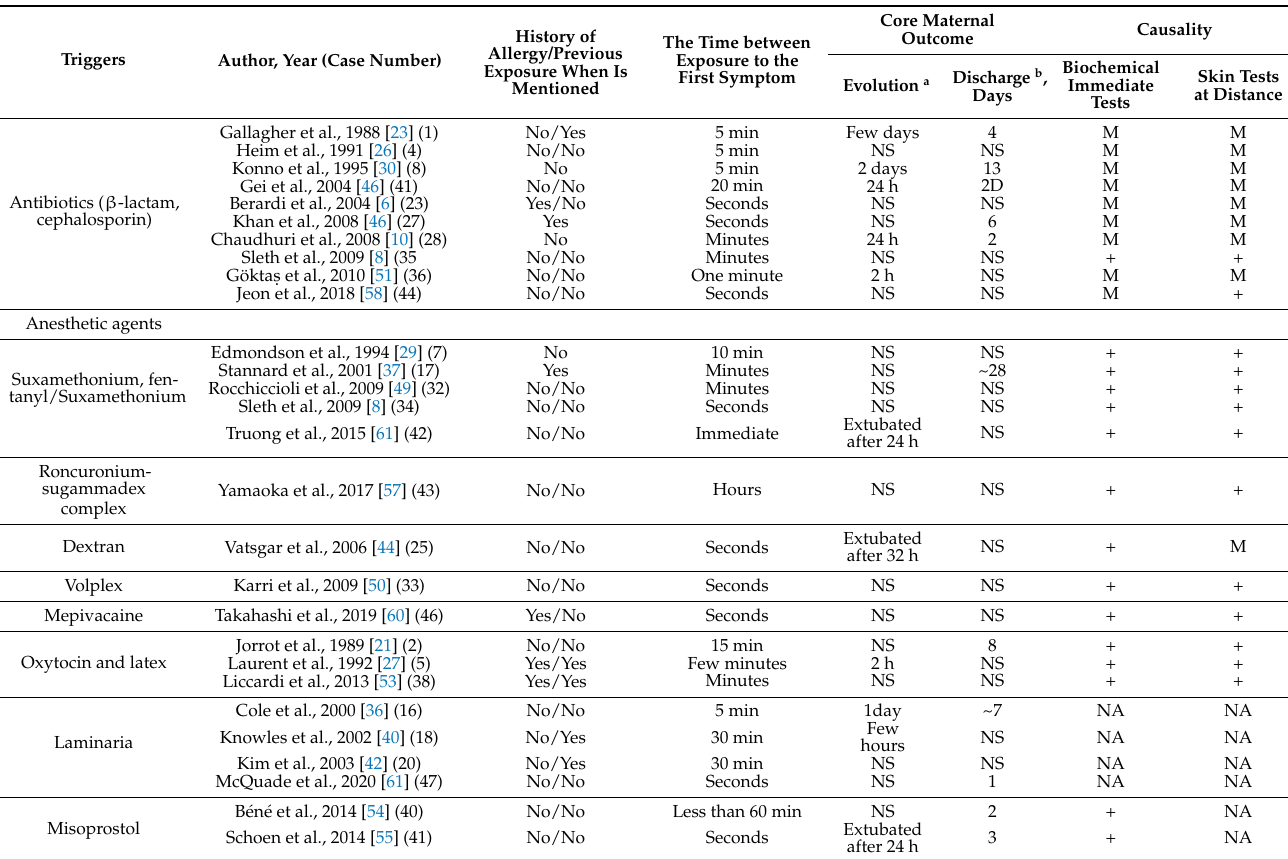
Table 2. Studies included in the systematic review of clinical features and symptoms of anaphylaxis in pregnancy and